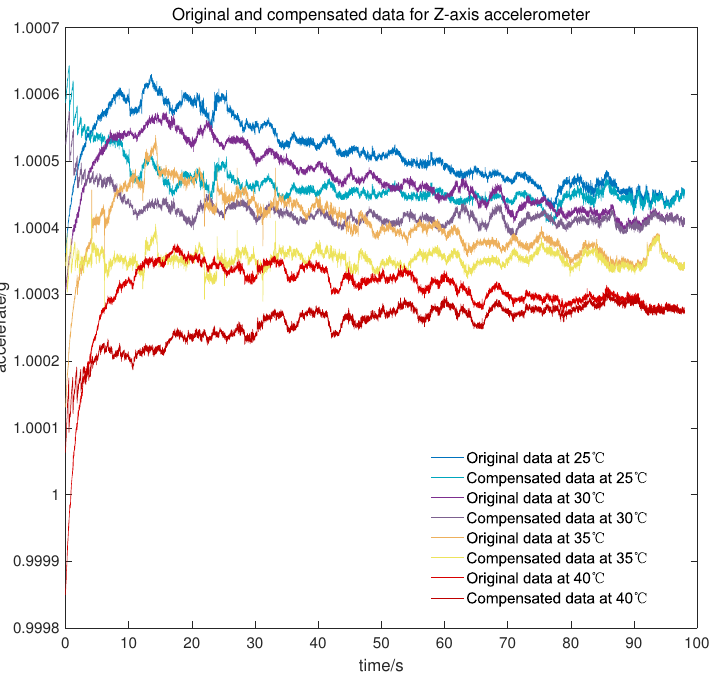
Figure 12. Original and compensated data for Z -axis accelerometer at different temperature points.